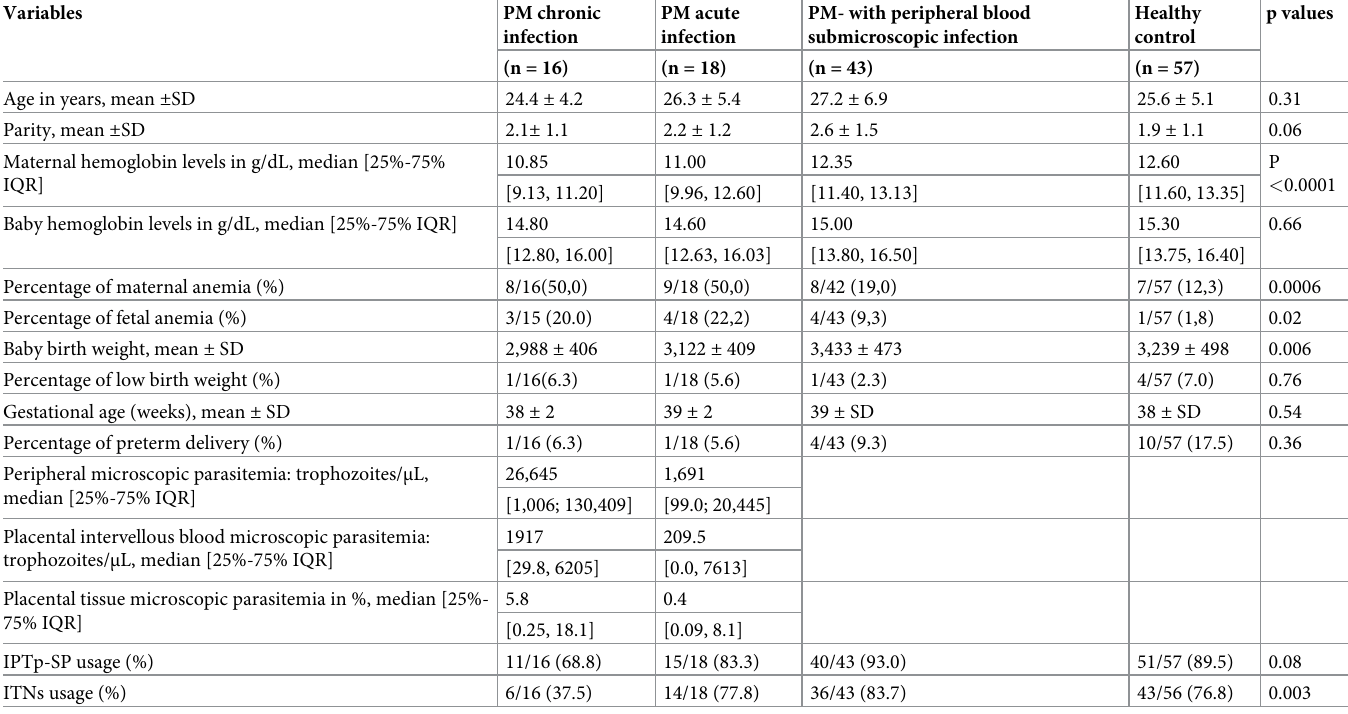
Table 1. Characteristics of the study population.